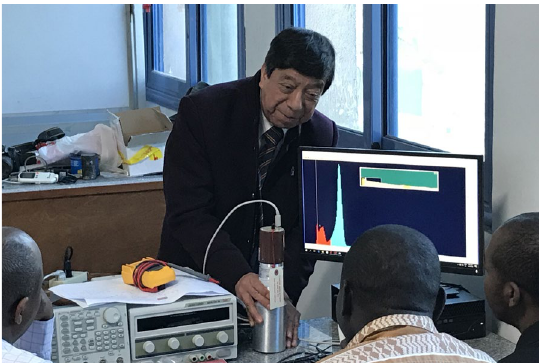
Fig. 1. Regional training course on operation and use of detectors in radiation technologies and measurement applications. Training course organized by the Nuclear Research Centre, Egyptian Atomic Energy Authority, Cairo, Egypt, in cooperation with the IAEA and with the support of international